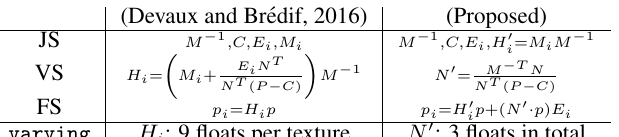
Table 1. Computation of the reprojection p i in texture i of the screen-space point p provided by FragCoord . The first line (JS) contains the uniforms computed on the CPU in javascript, (VS) shows the varying s evaluated in the vertex shader, and (FS) provides the evaluation of the texture coordinate p i in the fragment shader. P and N are the position and normal point attributes, N defaulting to ( P − C ) if